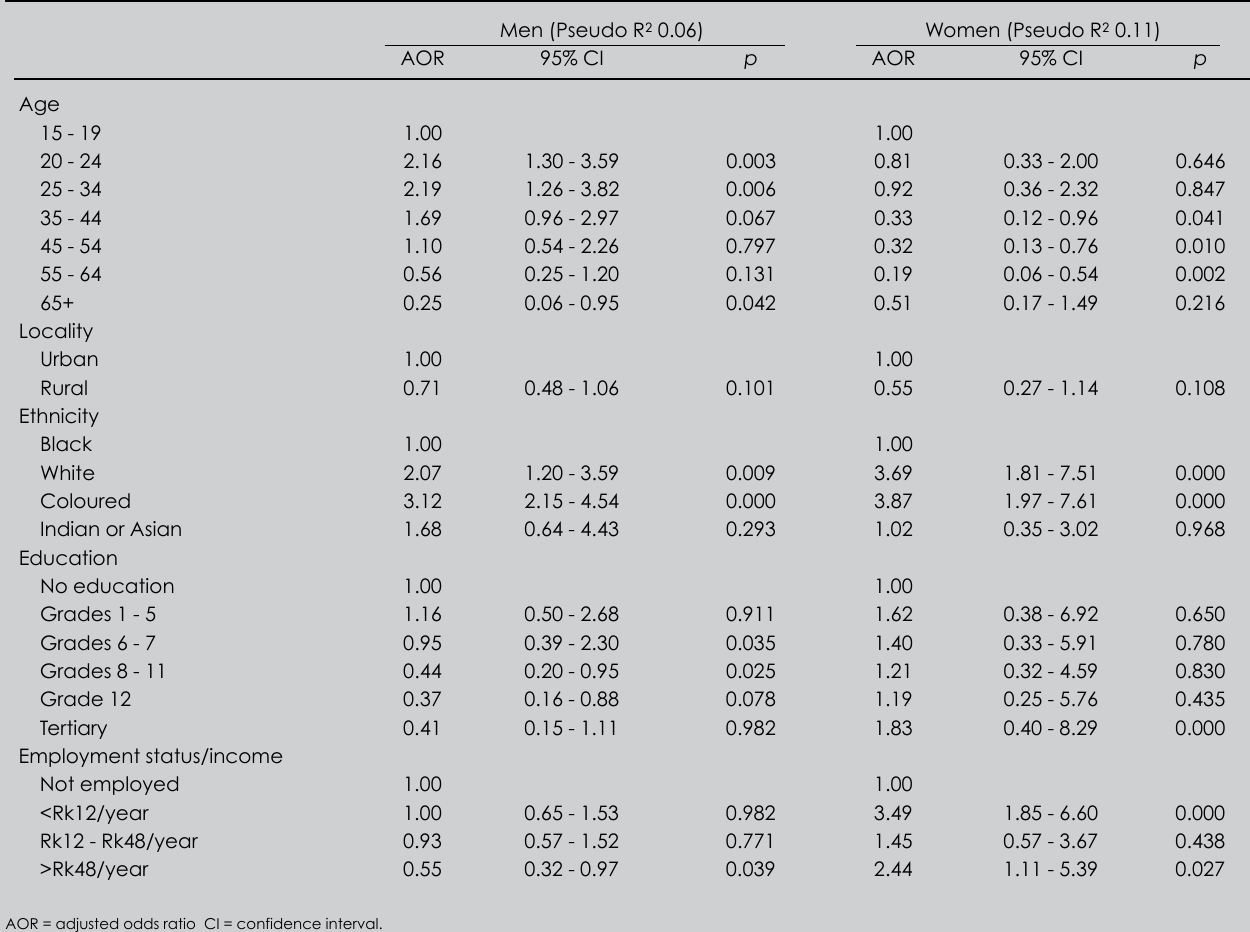
Table III. Logistic regression analysis of sociodemographic characteristics and illicit drug use (combined)